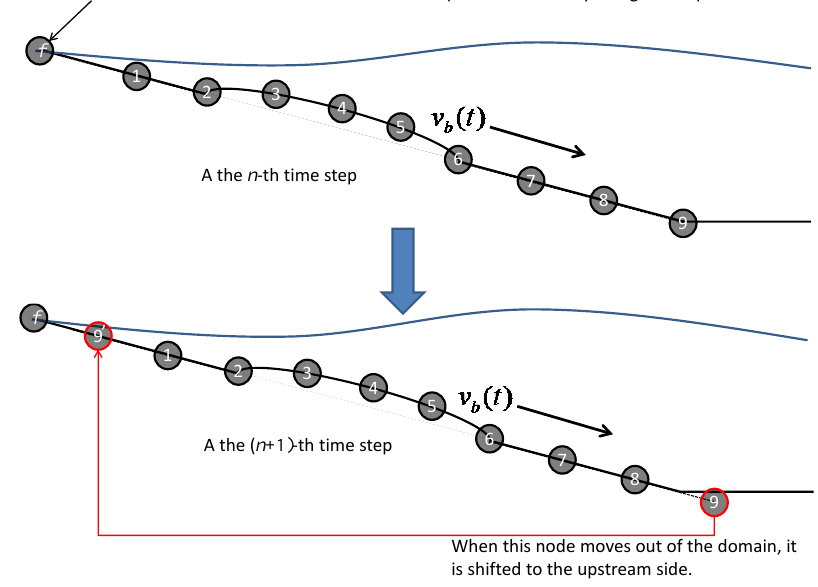
Figure 2. Shift of the collocation points (numbered circles) for the landslide moving boundary treatment.